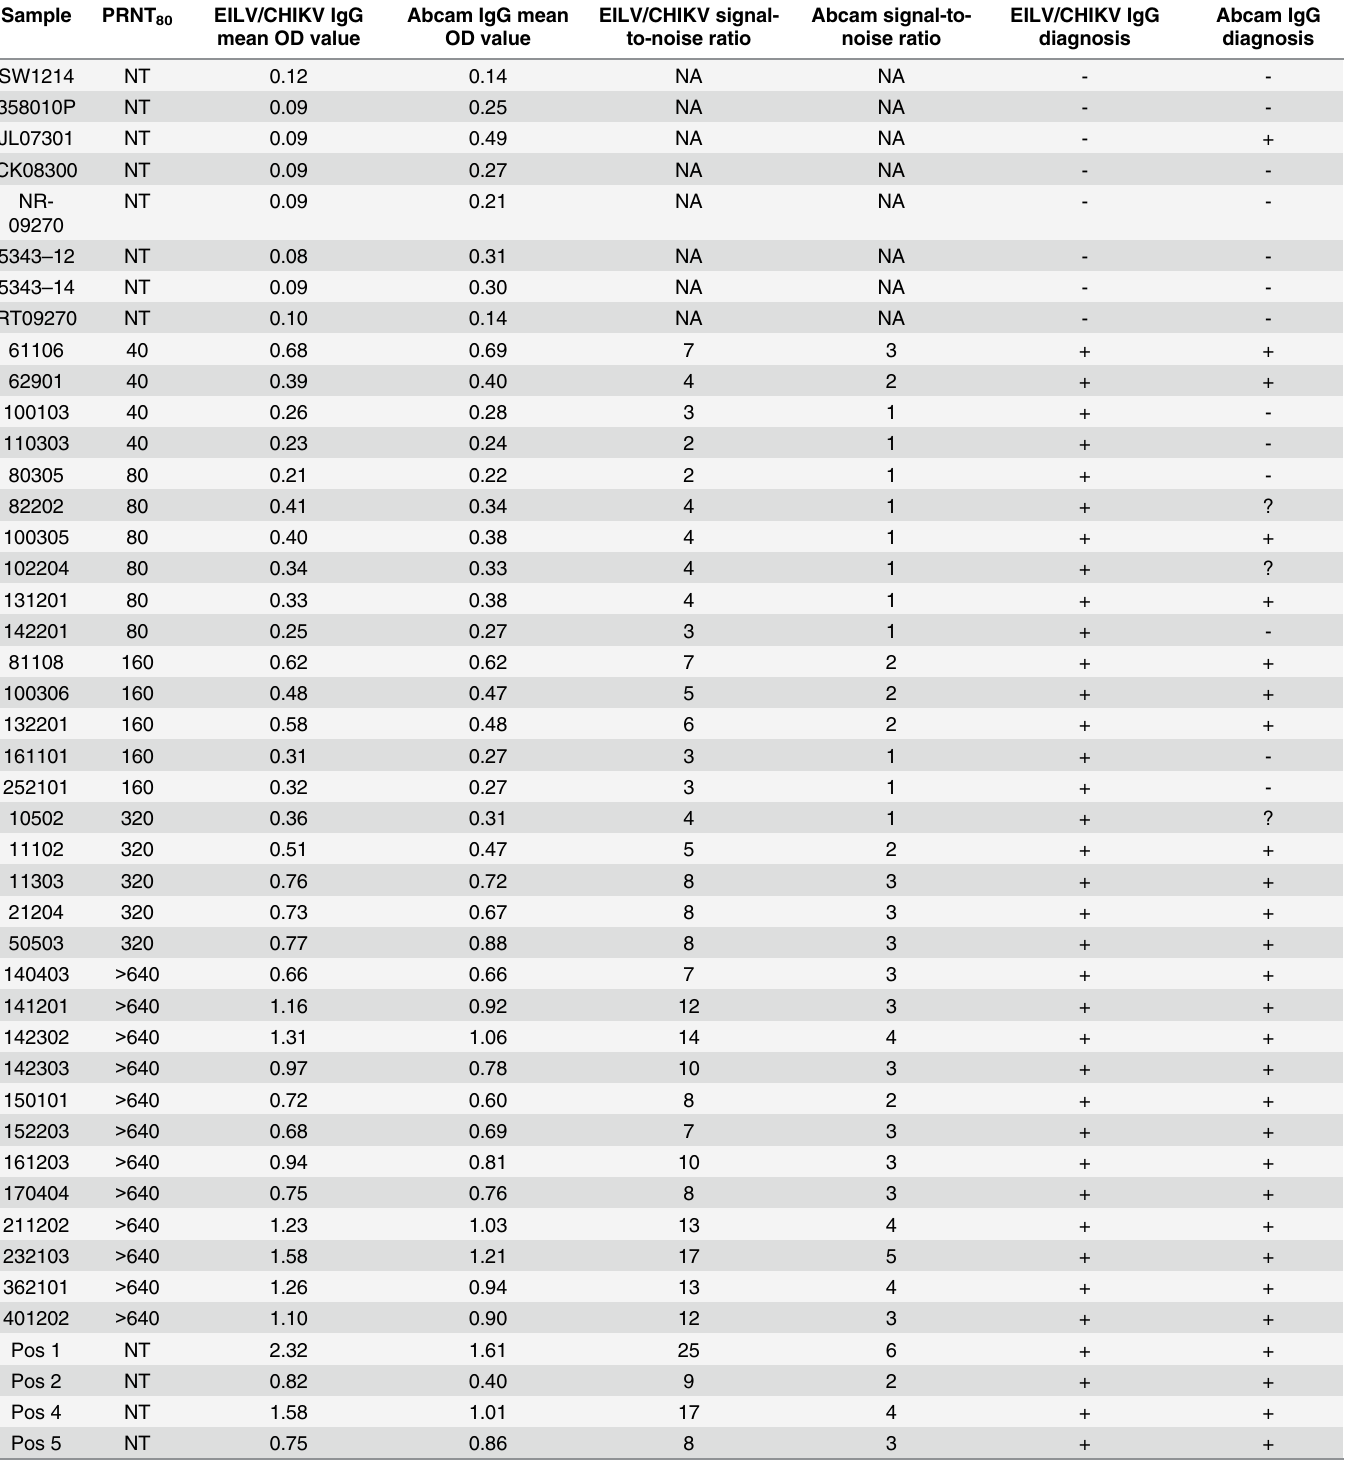
Table 2. Comparative IgG ELISA results using EILV/CHIKV and Abcam